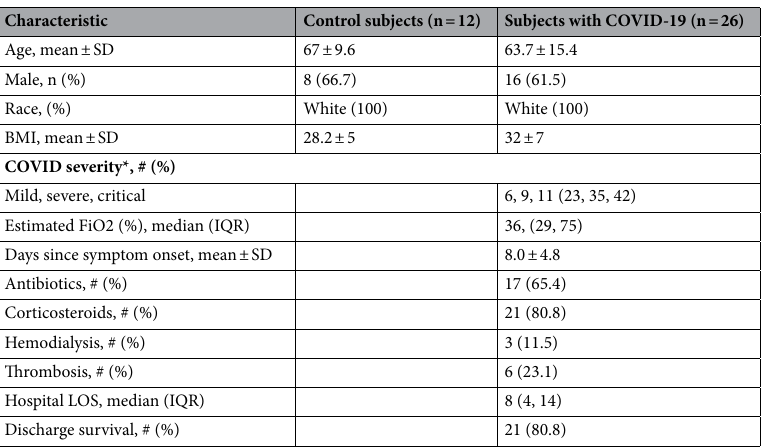
Table 1. Characteristics of control subjects and subjects with COVID-19. IQR interquartile range, FiO2 fraction of inspired oxygen, LOS length of stay. *Mild: no need for supplemental oxygen; Severe: supplemental oxygen required; Critical: critically ill with respiratory